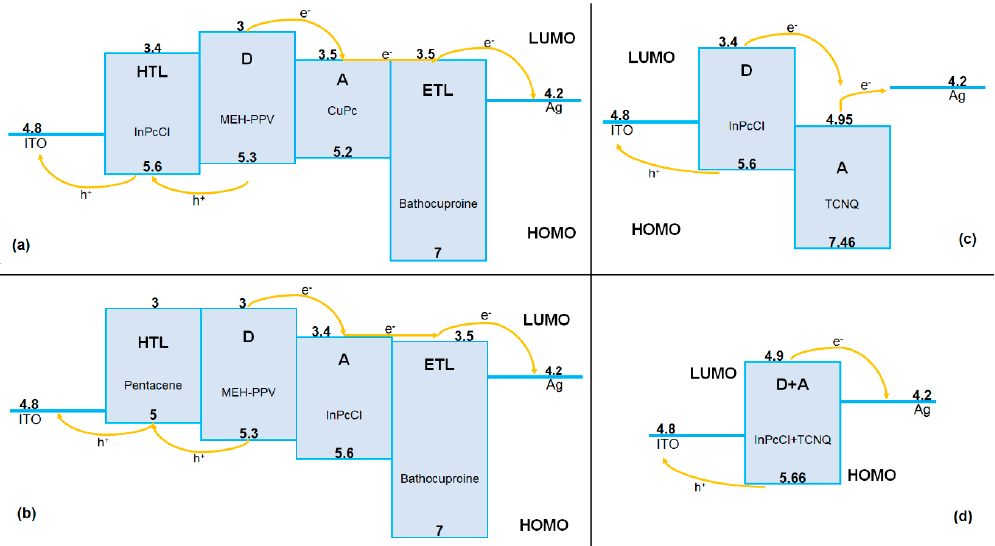
Figure 4. Schematic representation of the relative distribution of Highest Occupied Molecular Orbital (HOMO) and Lowest Unoccupied Molecular Orbital (LUMO) energetic levels in ( a ) D1 , ( b ) D2 , ( c ) D3 and ( d ) D4 components.